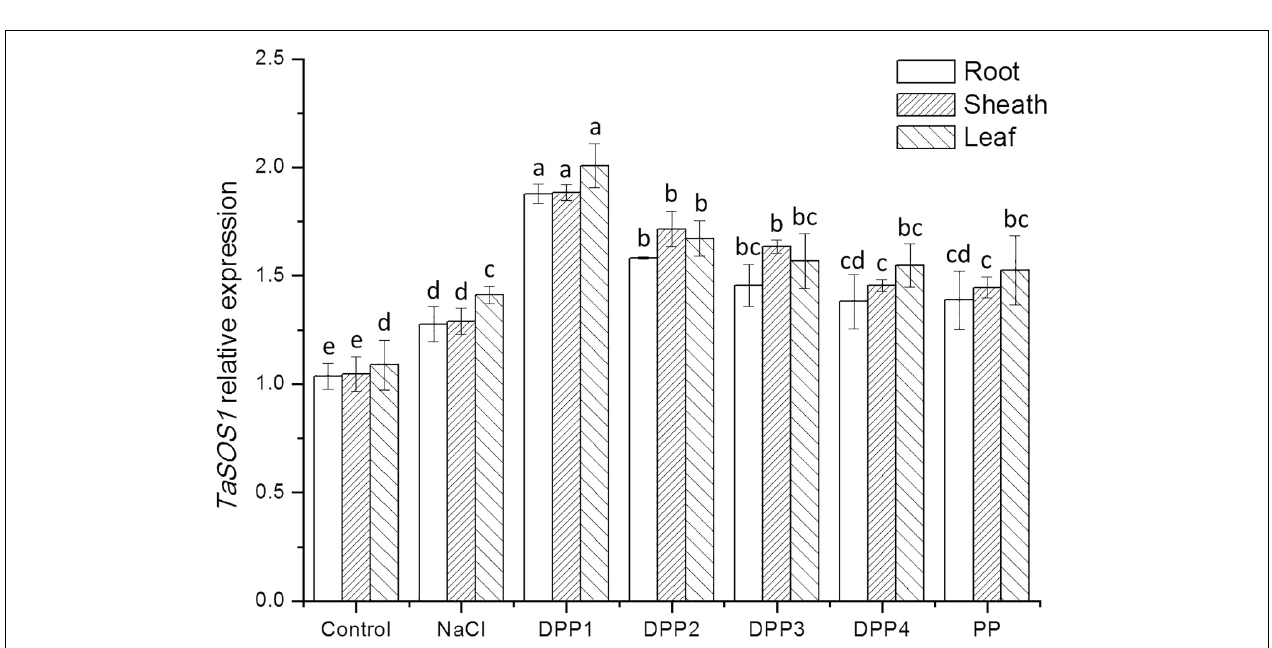
FIGURE 11 | Effect of four degraded (DPP1,2,3,4) and natural polysaccharides (PP) from P. yezoensis on TaSOS1 expression of root, sheath, and leaf in wheat seedlings. Values are the mean ± SD of three replicates. Different letters indicate significant differences at P < 0.05.